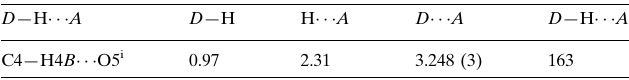
Hydrogen-bond geometry (A˚ , (cid:2)